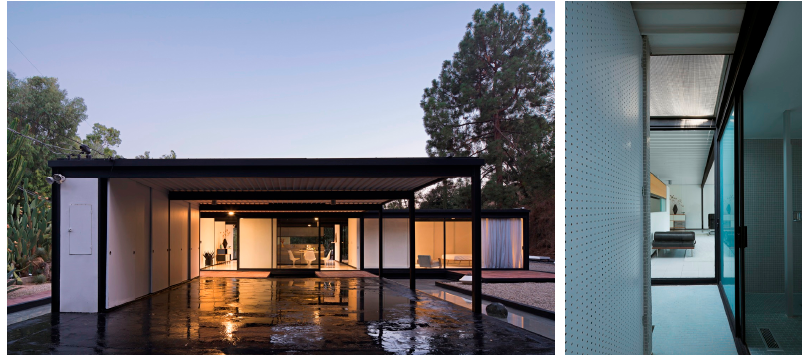
Figure 12. CSH#21 by Pierre Koenig, West Hollywood, 1958–1960 [23].